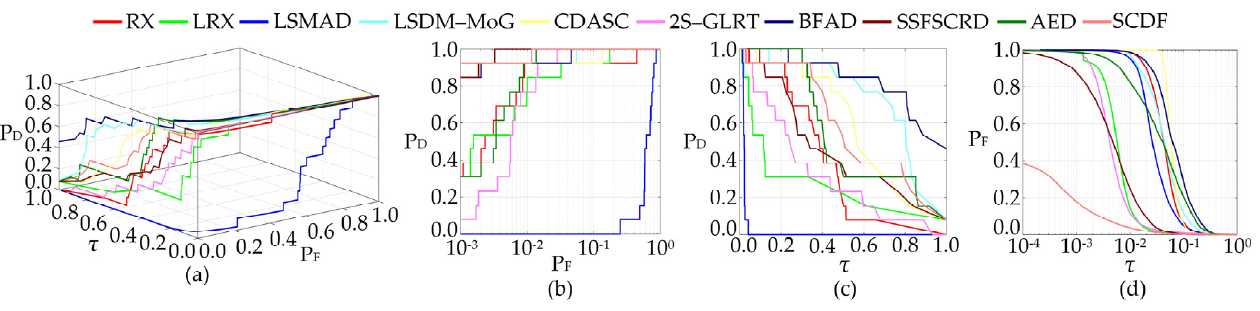
Figure 13. The 3D ROC curve and corresponding 2D ROC curves of different methods on the urban